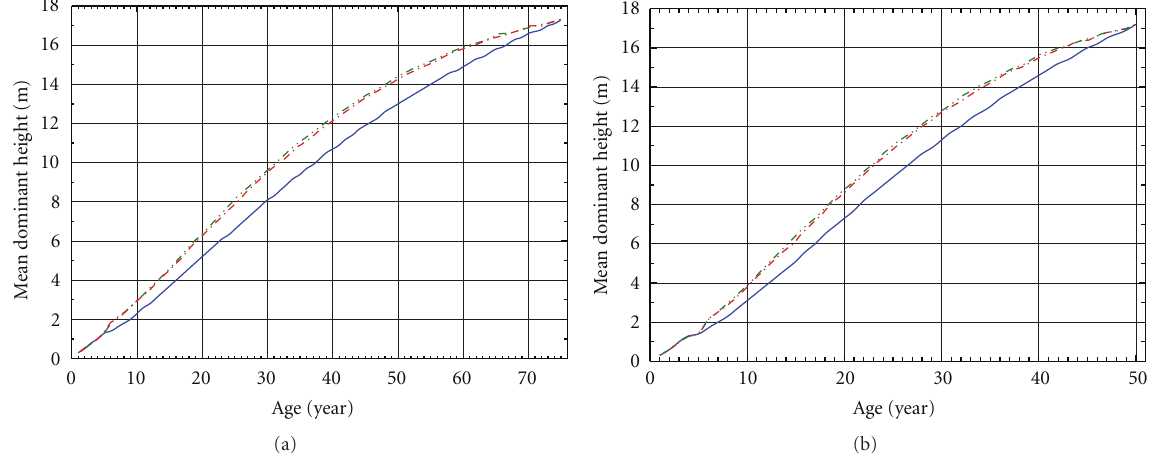
Figure 3: Type I response pattern as reflected in the mean dominant height-age relationship for poor-medium (a) and good-excellent (b) site qualities: Regime 1: no FVM treatment applied (solid line); Regime 2: FVM treatment with an expected e ff ect of a 15.7% gain at age 7 (long-short dash line); and Regime 3: FVM applied with an expected e ff ect of a 40.0% gain at age 7 (long-short-short dash